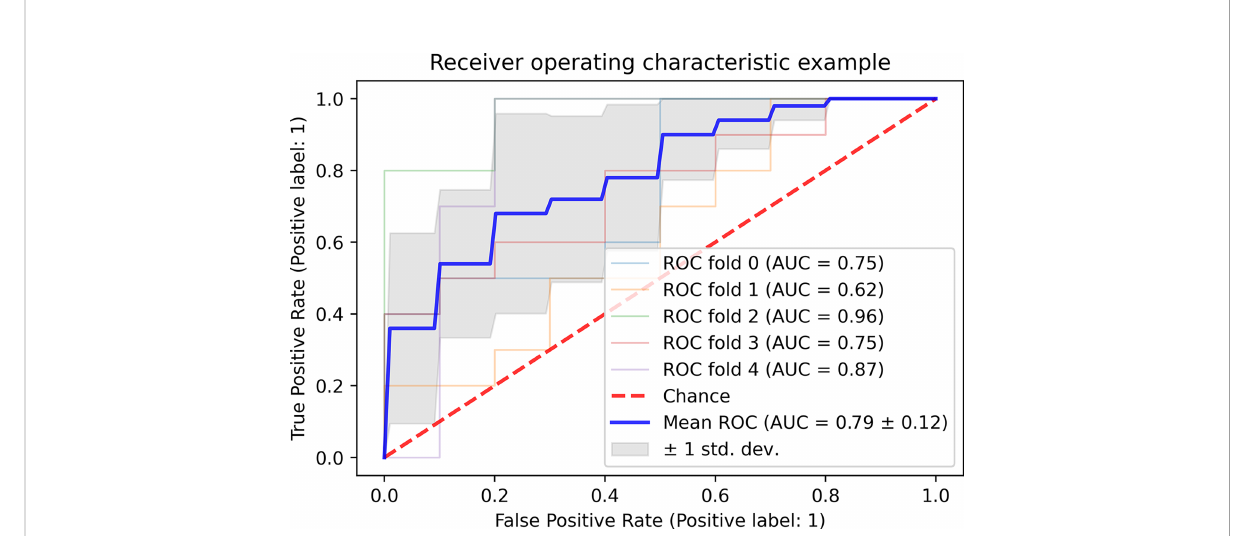
FIGURE 4 The classi fi cation of the patients with MS and NMOSD based on FN and FA of short-, middle- and long fi ber. MS, multiple sclerosis; NMOSD, neuromyelitis optica spectrum disorder; FN: fi ber number; FA, fractional anisotropy; ROC, receiver operator characteristic curve; AUC, area under